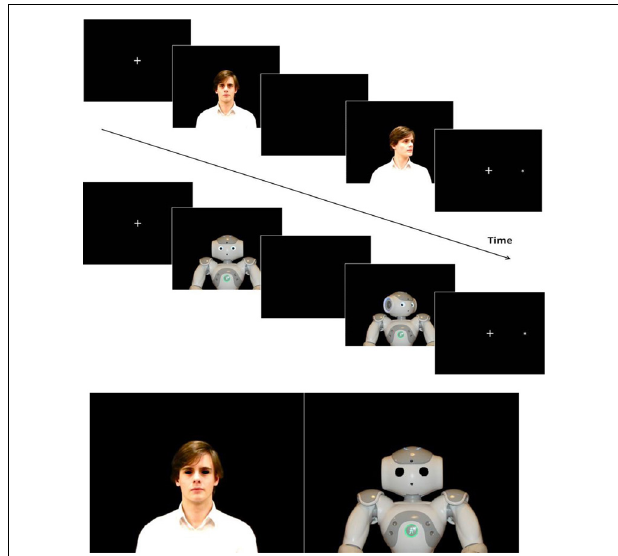
FIGURE 1 | Top: Schematic representation of the sequence of events in a trial defined by the target appearing on the right of the agent ( top : human, bottom : robot) and a valid cue. Bottom: Neutral stimuli used in experiment